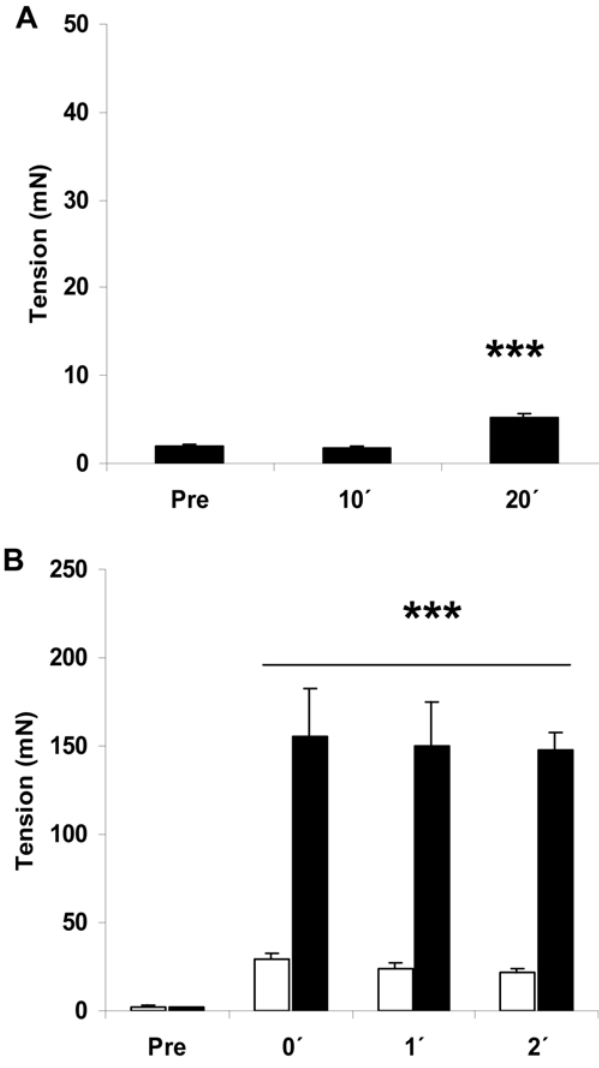
Figure 1. Tension-measurements. Tension-development during A) H2O2 stimulation (3 mM, 20 min) and B) twitch (white bars: 0.1 ms, 2 Hz, 2 min) and tetanic (black bars: 0.2 ms, 100 Hz, 1s/15s, 2 min) stimulation in mouse soleus muscles (n= 5–8). *** p , 0.001 vs.